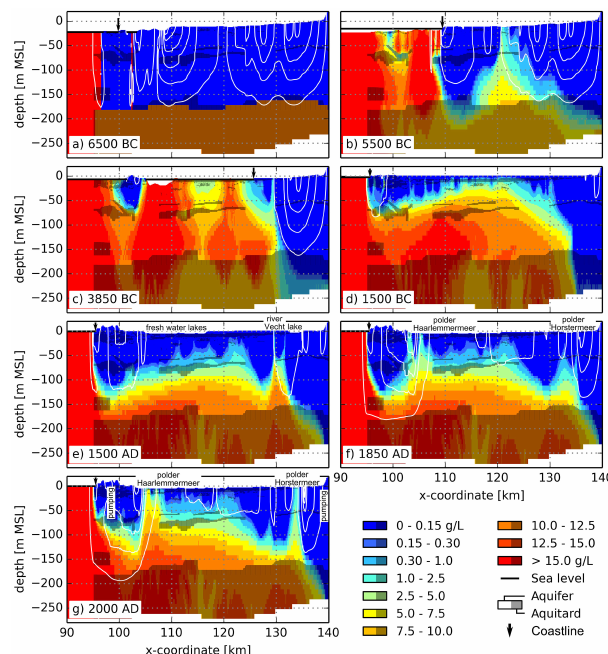
Figure 7. Modeled evolution of groundwater chloride concentra- tion (a–g) . White lines are contours of the stream function, contour intervals are equal for all time slices. Except for (a) (starting con- centration), transect times correspond to paleo-geographical maps in Fig. 2.